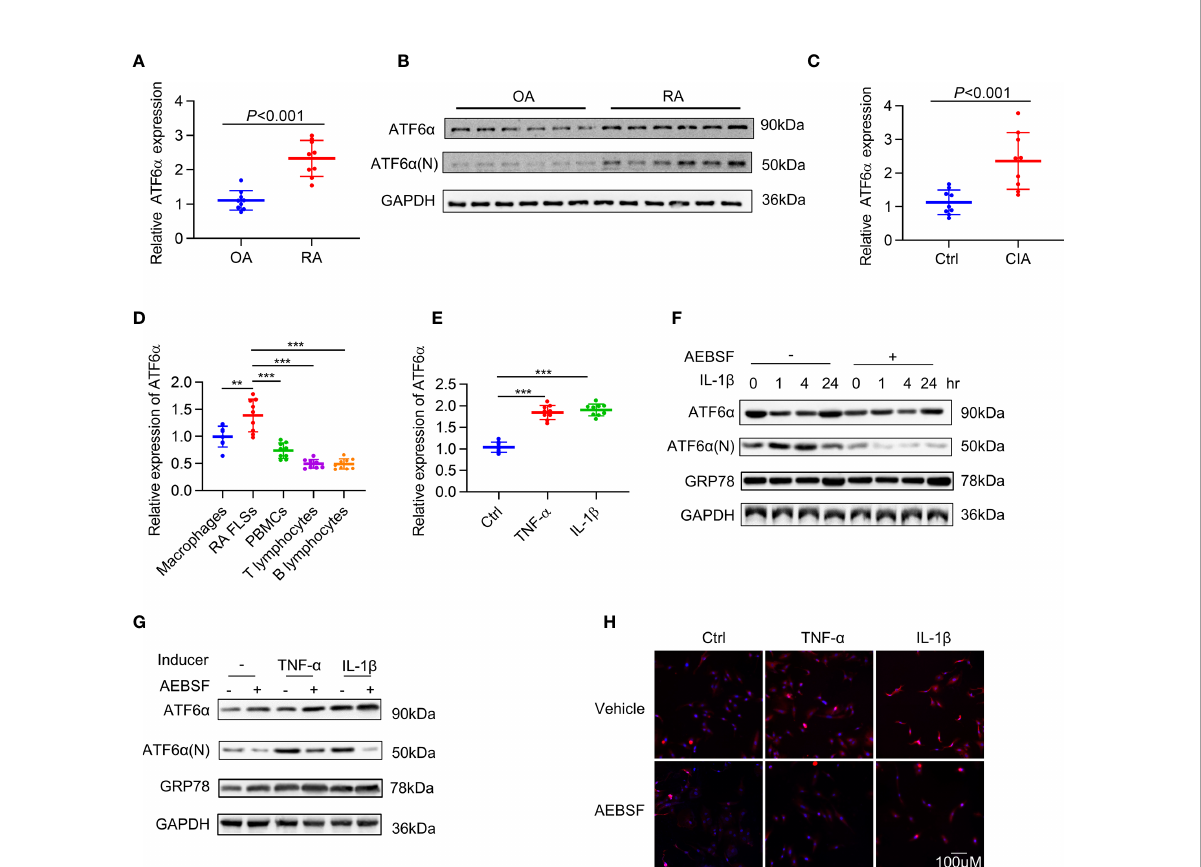
FIGURE 1 Expression of ATF6 a in RA. ATF6 a mRNA (A) and protein (B) expression was assessed in RA FLSs and OA FLSs. (C) ATF6 a mRNA expression was assessed by qPCR in the knee joints from normal DBA1 mice (Ctrl) and CIA mice. (D) ATF6 a mRNA expression levels were measured by qPCR in indicated cells from RA patients. (E) RA FLSs were stimulated with TNF- a (10 ng/mL) or IL-1 b (10 ng/mL) for 24 h and ATF6 a mRNA expression was assessed by qPCR. (F – H) RA FLSs were pretreated with (+) or without (-) 300 m M AEBSF for 1 h and subsequent TNF- a (10 ng/mL) or IL-1 b (10 ng/mL) for the indicated time periods (F) or 6h (G, H) . (F, G), Western blotting was performed to detect ATF6a and GRP78 expression. (H) , The cells were then stained with anti-ATF6 a antibody (red signal) and DAPI (blue signal). Representative images are shown at 40X magni fi cation. Data were expressed as mean ± SD ( n = 9), n represent biologically independent samples (A, C – E) . The data were analyzed using two-tailed unpaired Student ’ s t test (A, C) and one-way ANOVA (D, E) . ** P < 0.01, *** P < 0.001. ATF6 a (N): N-terminal fragment of ATF6 a ; AEBSF: 4-(2- aminoethyl) benzenesulfonyl fl